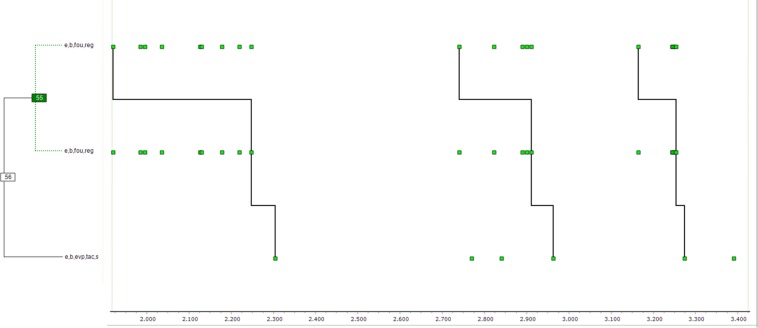
This figure highlights bursts, here providing a rule (reg) for the solution at each stage, followed by a positive evaluation of progress (evp) by one of the two, talking to herself (s = soliloquy). Each of the behaviors in the burst clearly has little predictive behavior, but an occurrence of the burst each time predicts the positive evaluation.